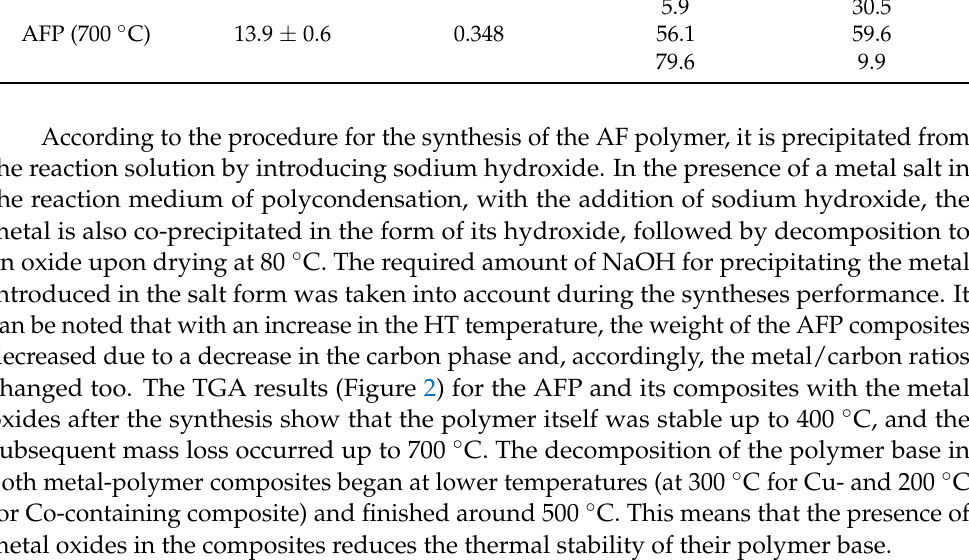
3 ) 2 (blue) and AFP + Co(NO 3 ) 2